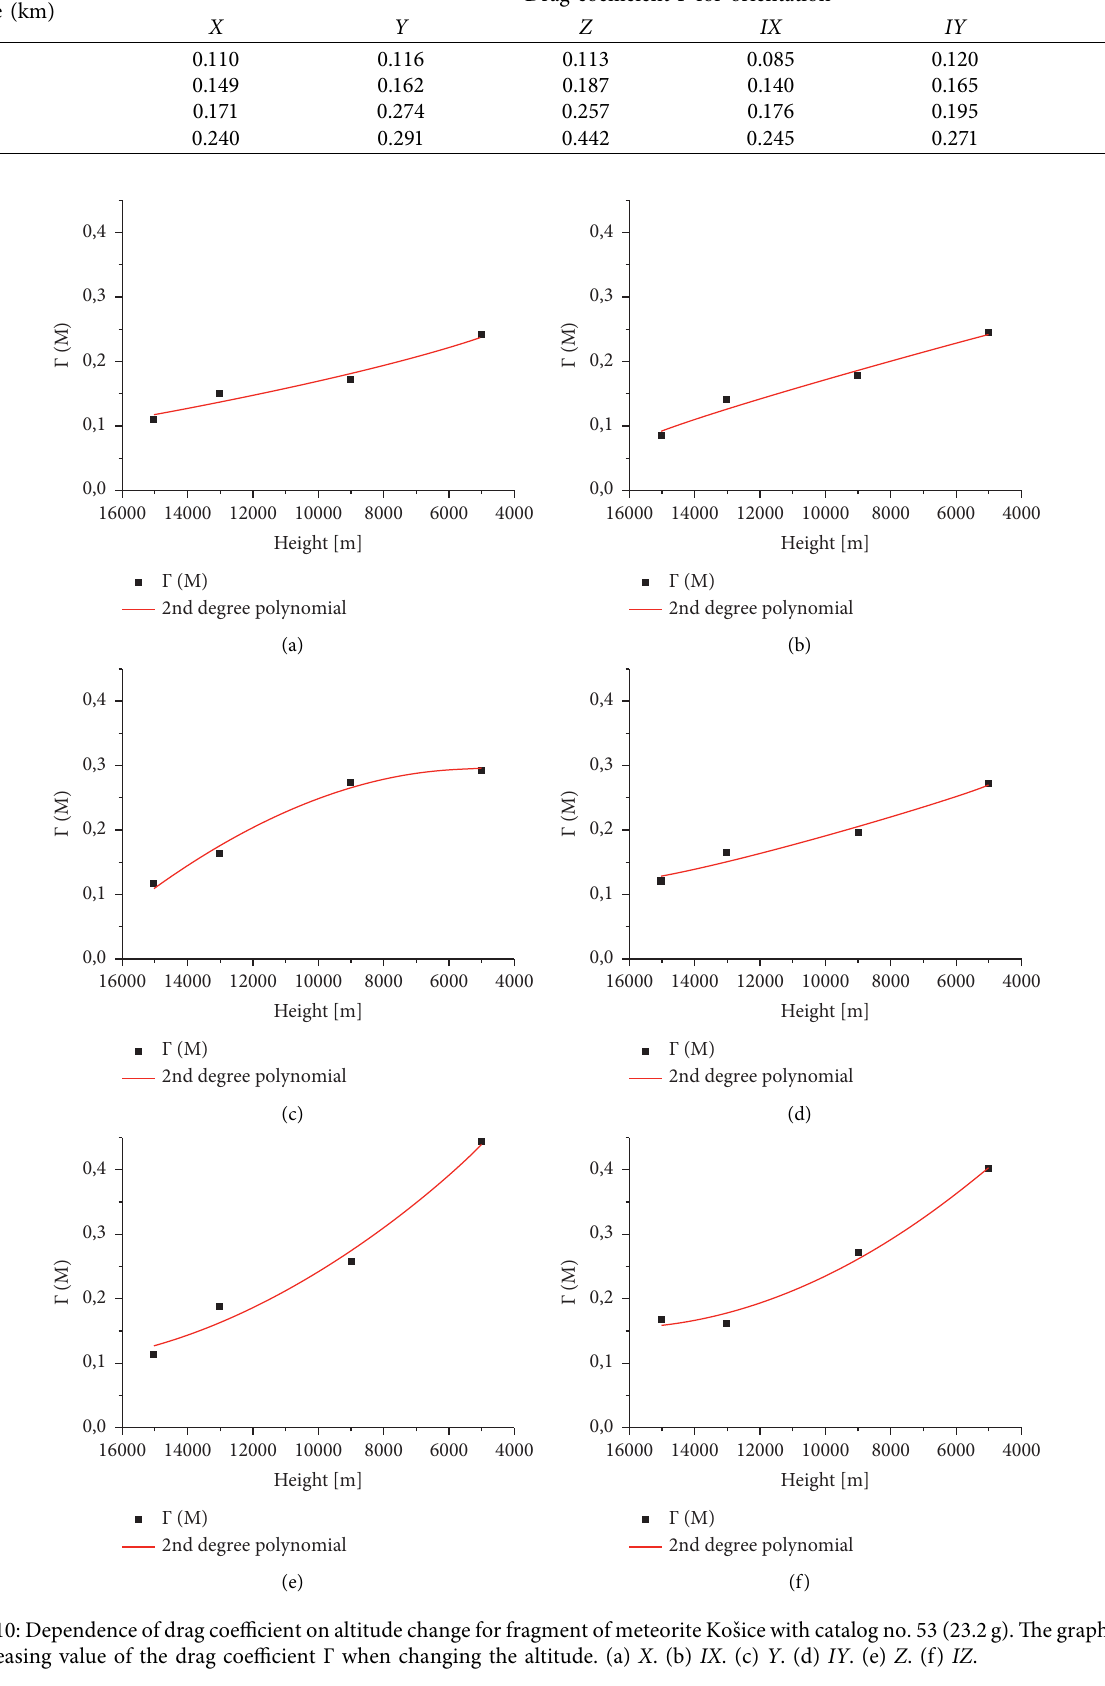
Table 4: Values of the drag coefficient Γ for individual orientation of the Koˇsice fragment no. 53 (23.2 g) in selected altitudes [15] . Altitude